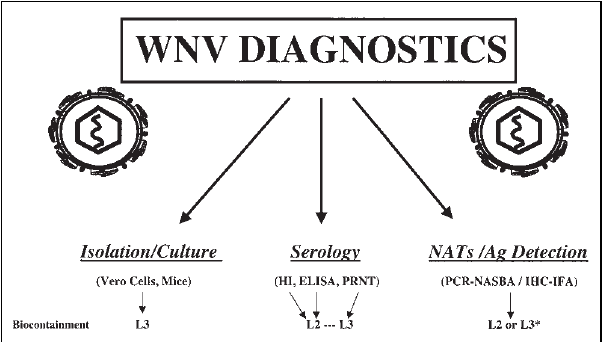
Figure 1) West Nile virus diagnostic platforms (including biocontain- ment levels at which procedures are performed). *The manipulation of bird tissue may require level 3 (L3) containment. This is advised due to high viral load in infected corvids and other bird species. Ag Antigen; HI Hemagglutination inhibition; IHC-IFA Immumohistochemistry- immunofluorescence assay; L2 Level 2; NASBA Nucleic